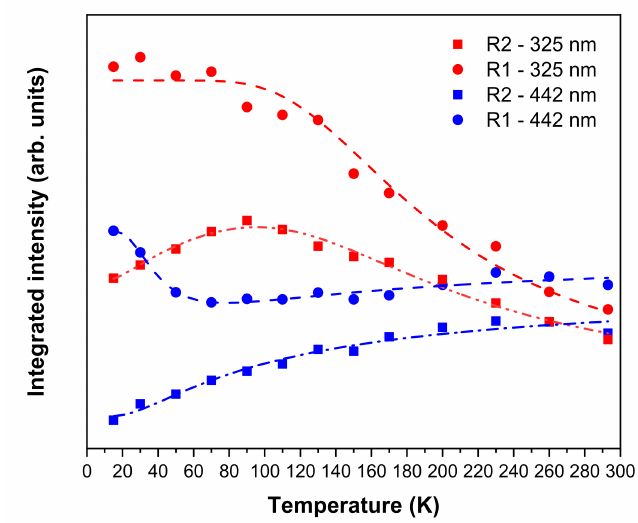
Figure 9. Temperature dependence of the R-lines’ integrated intensity obtained under 325 nm and 442 nm photon excitation and correspondent fittings according to Equations (1) and (2).